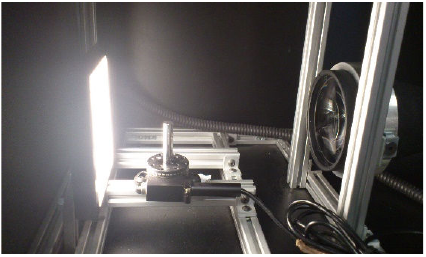
Figure 8. Cylinder images acquisition.